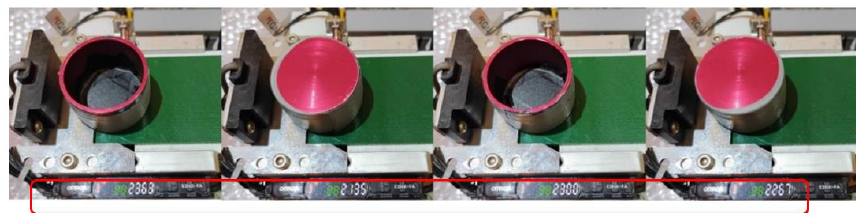
Figure 9. Test values of circular gray material.